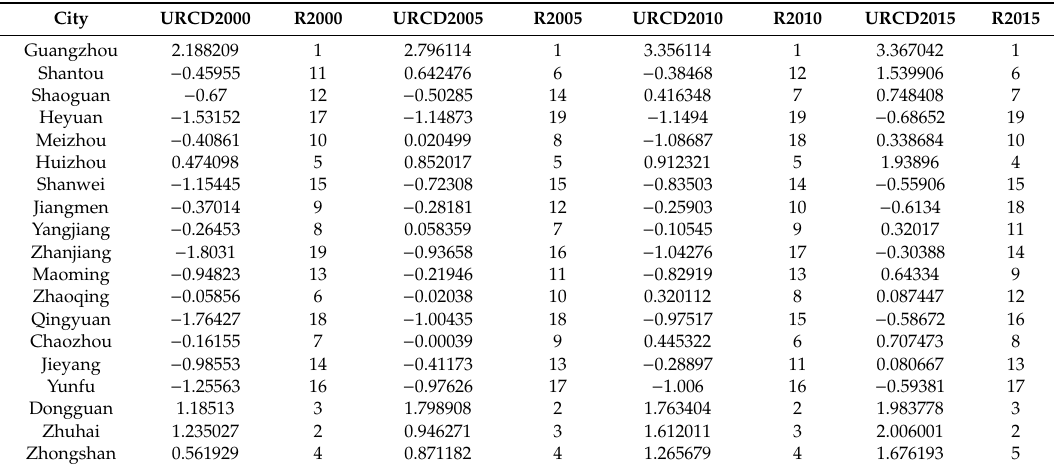
Table 2. The value and range of the Urban–Rural Coordination Development